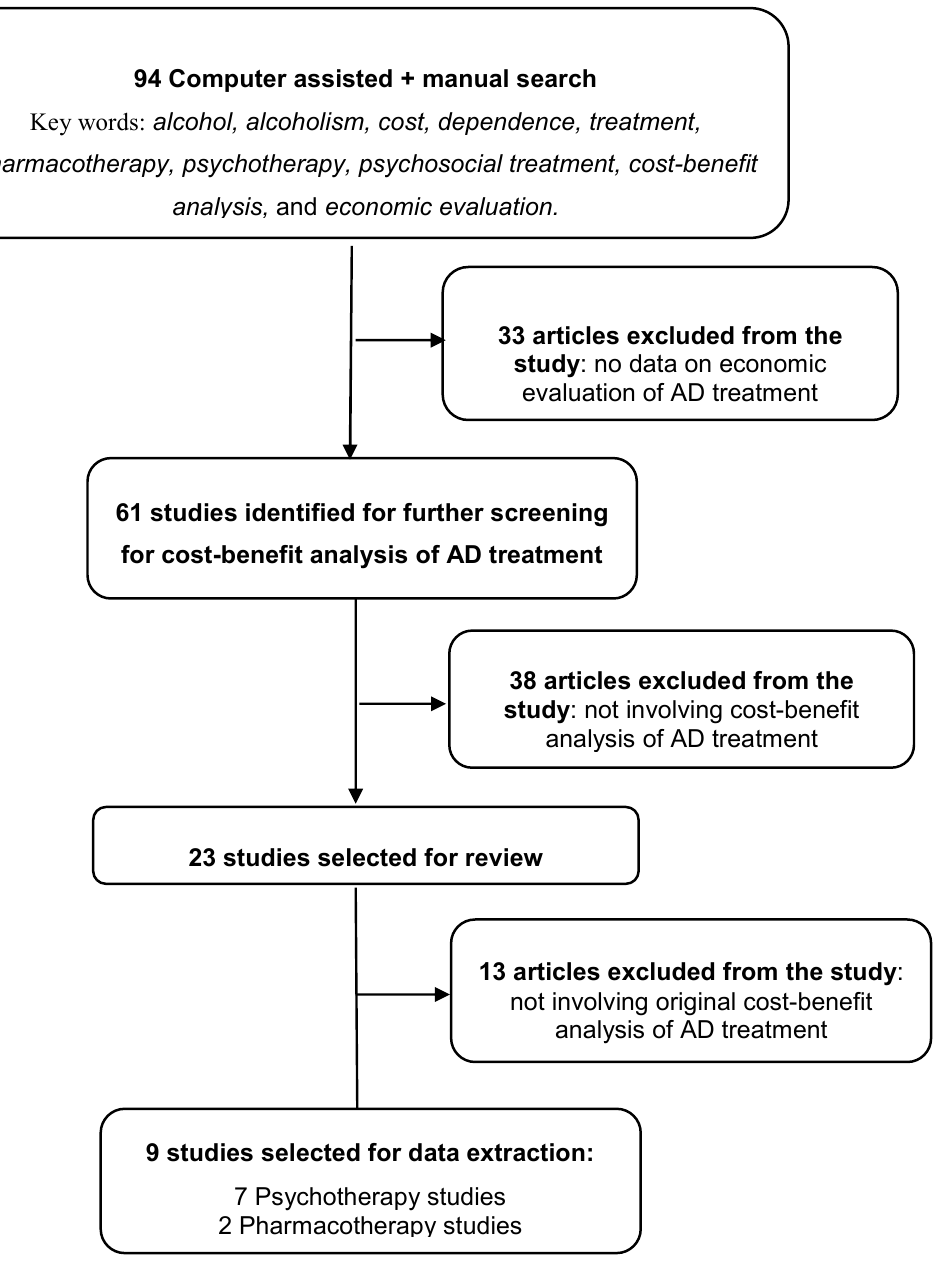
Figure 1. Flow diagram describing the search strategy for cost-benefit studies of alcohol dependence